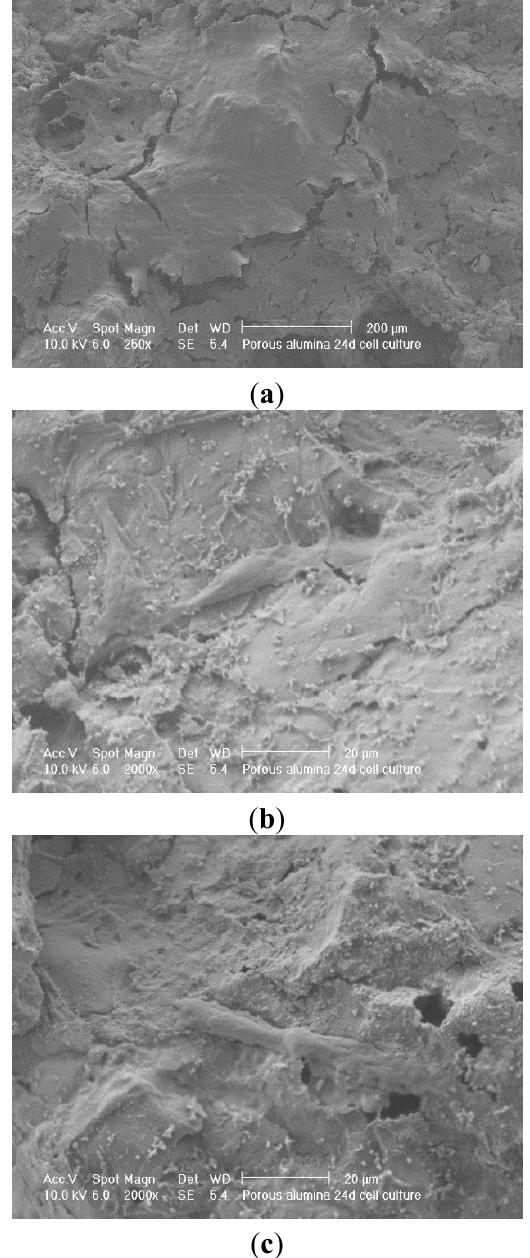
Figure 12. SEM micrographs of 24d culture on porous alumina Sample A; ( a ) no cells on alumina; ( b ) cells attaching to calcium phosphate particles; ( c ) single cell on alumina